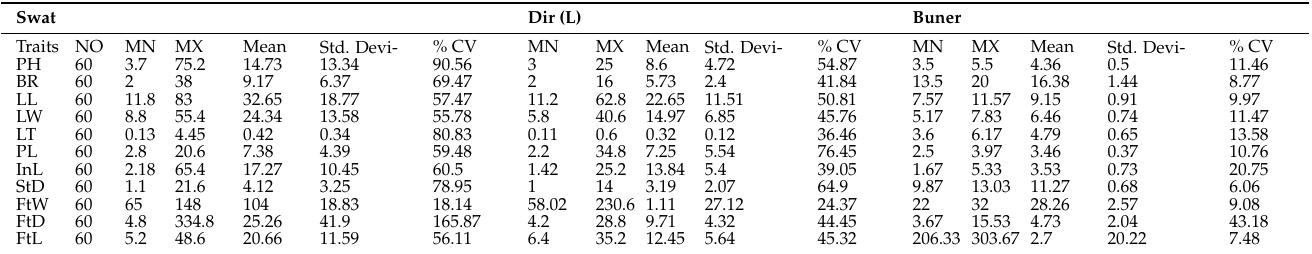
Table 2. Descriptive Statistics of Z. nummularia genotypes collected from different geographical regions of KP,